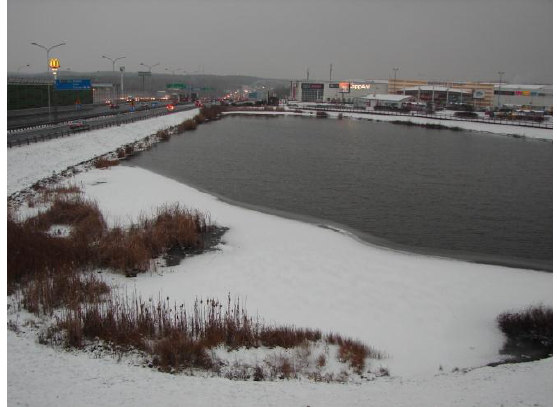
Fig. 4. Partial ice cover within reservoir in the period of its freezing ( R. Machowski